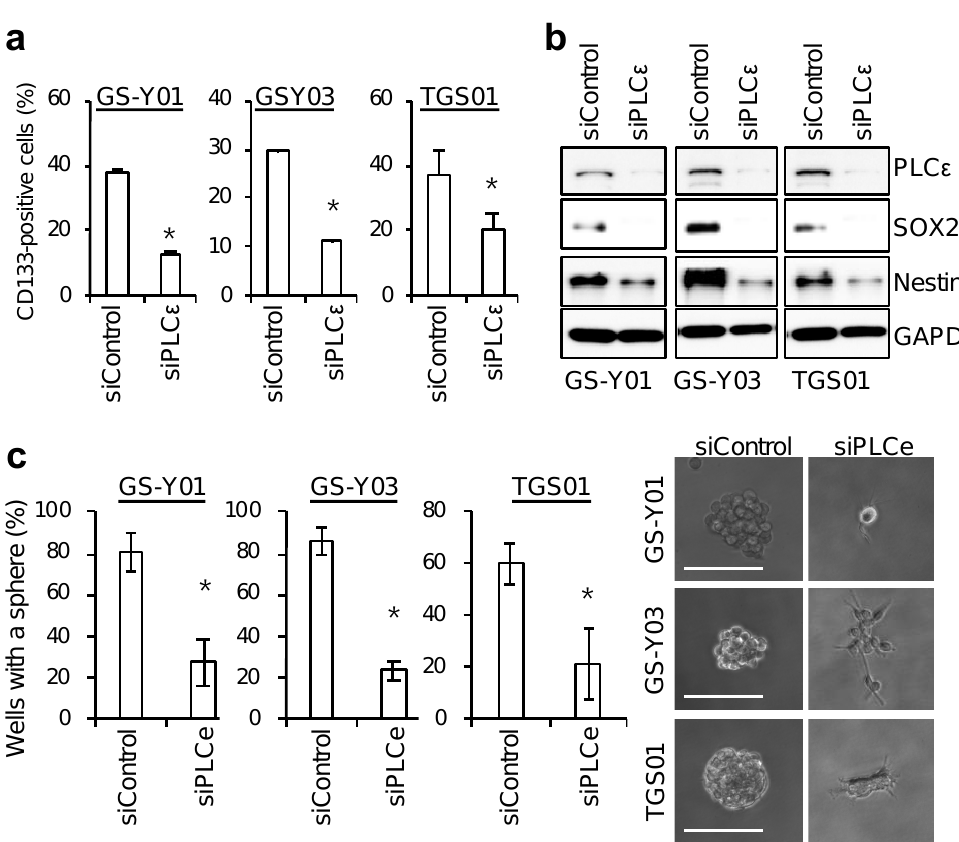
Figure 3. Genetic silencing of PLC ε by siRNA suppresses the stemness of GSCs. ( a ) GSCs were transiently transfected with siRNA against PLCE1 or control siRNA. After 4 days, the transfected cells were subjected to flow cytometric analyses for the cell surface expression of CD133. The graphs show the means + SDs of triplicate samples. Representative flow cytometric histograms are shown at Supplemental Figure S3. ( b ) Cells that were transfected as in ( a ) were subjected to Western blot analyses for the expression of the indicated proteins. ( c ) Cells that were transfected as in ( a ) were subjected to sphere-forming analyses. Graphs show the means ± SDs of triplicate samples (left). Representative photographs of spheres are shown (right). Bars: 100 µ m. Similar results were obtained from two independent biological replicates. * p < 0.05 vs. siControl-transfected cells by the Student’s t -test.